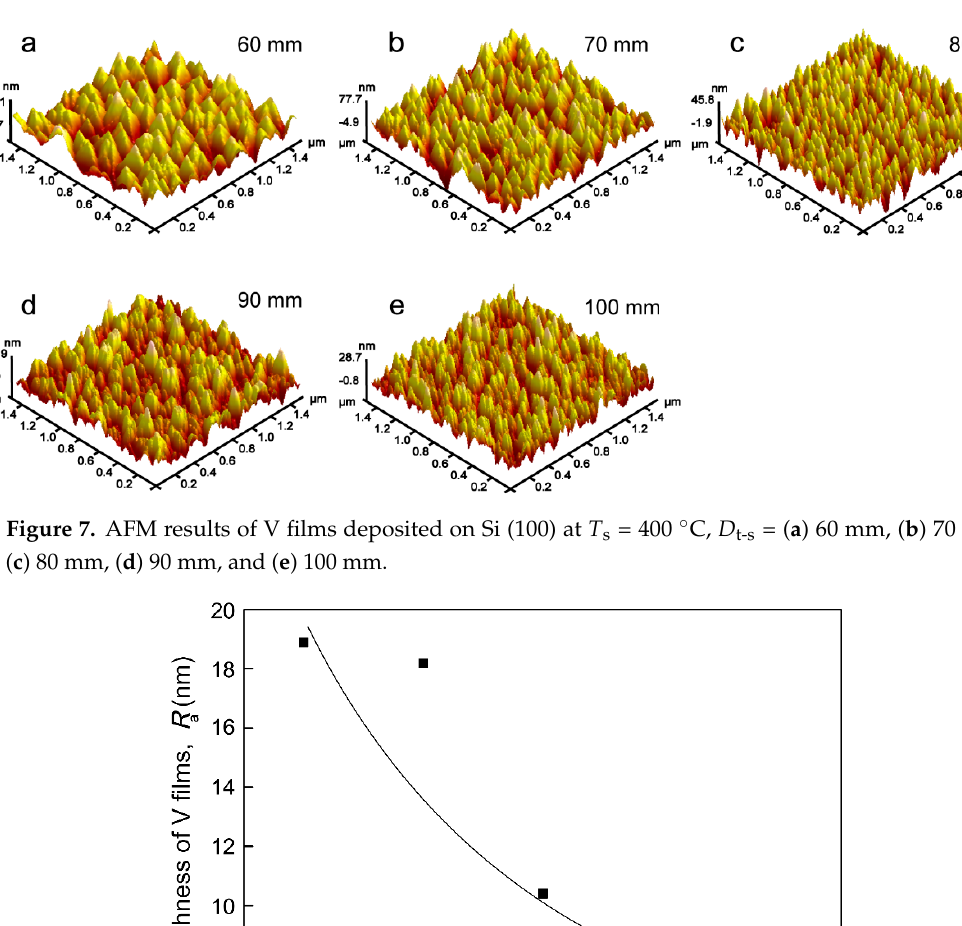
Figure 6. SEM images of the V films deposited on Si (100) at T s = 400 °C, D t-s = ( a ) 60 mm, ( b ) 70 mm, ( c ) 80 mm, ( d ) 90 mm, and ( e ) 100 mm.